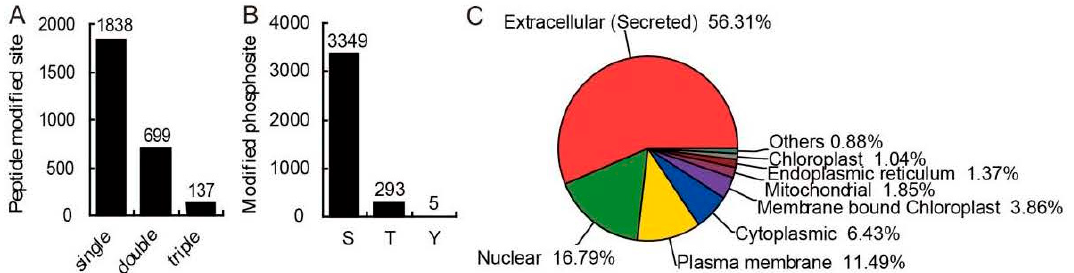
Figure 2. Phosphosite types and the subcellular location of phosphoproteins. ( A ) The frequency of phosphopeptides carrying one, two or three phosphosites; ( B ) The distribution of phosphosites between serine (S), threonine (T) and tyrosine (Y) residues; ( C ) The putative subcellular location of the set of phosphoproteins.